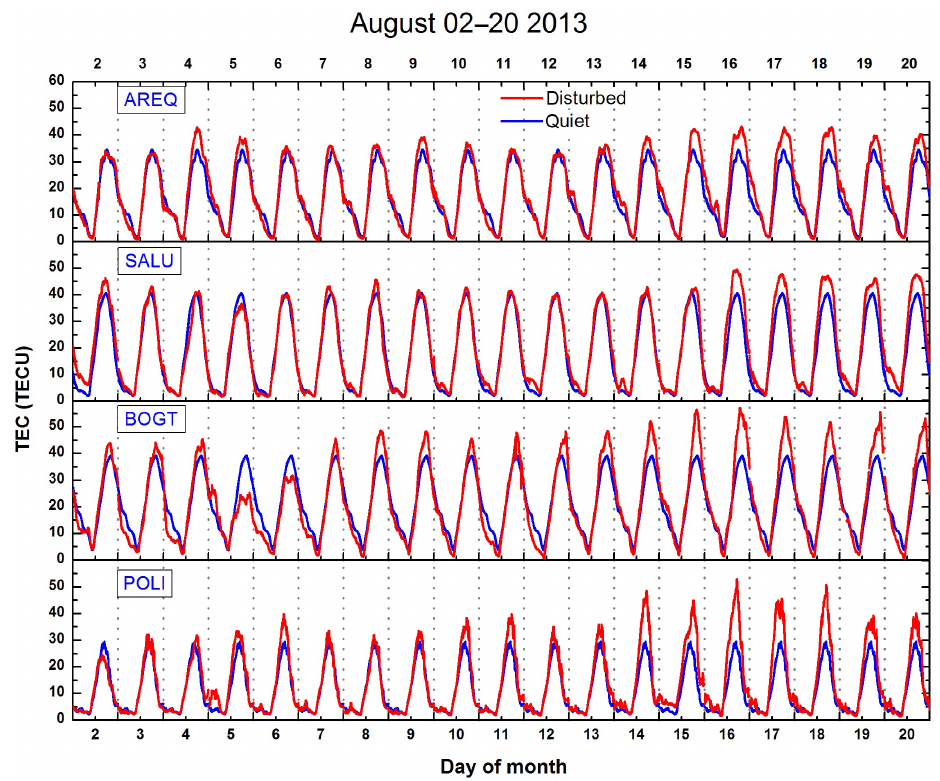
Figure 8. TEC measured over the equatorial GPS stations Areq and Salu, and the EIA crests stations Bogt (north) and Poli (south), for the period 2–20 August 2013. The blue line shows the quiet-time reference (average of 6 previous quiet days) and the red line shows the disturbed